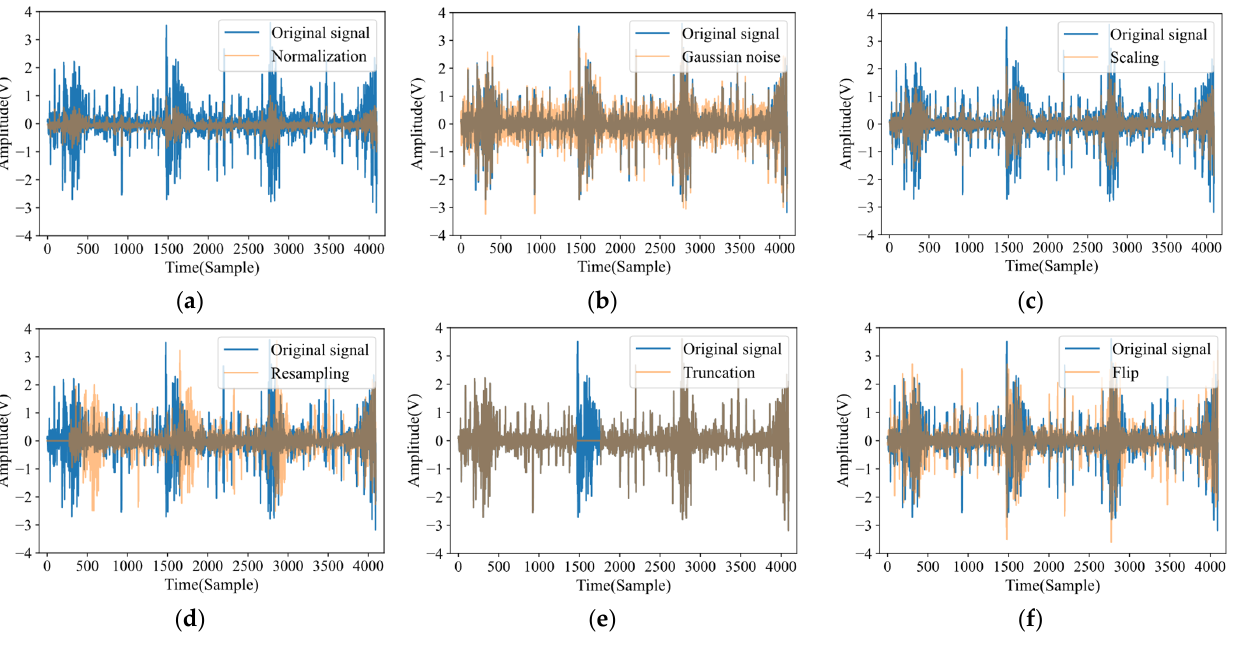
Figure 3. Data augmentation of sampled signals. ( a ) Normalization; ( b ) Gaussian noise; ( c ) scaling; ( d ) resampling; ( e ) truncation; ( f ) flip.